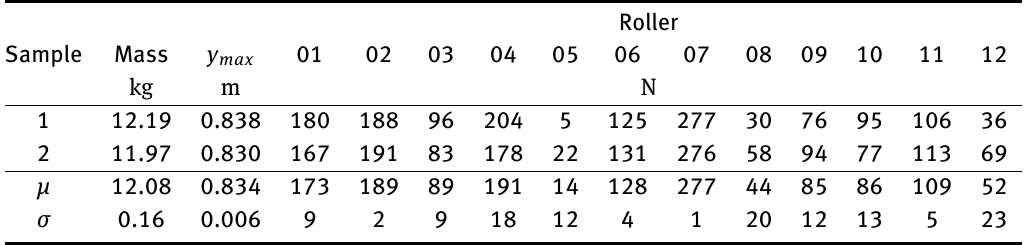
Table 1: Results from the six-point stiffness test of the two 0.15m wide belt samples. For every sample the sample’s weight, troughability and the force on roller 01 to 12 is shown. Last two rows arithmetic mean and standard deviation of measured